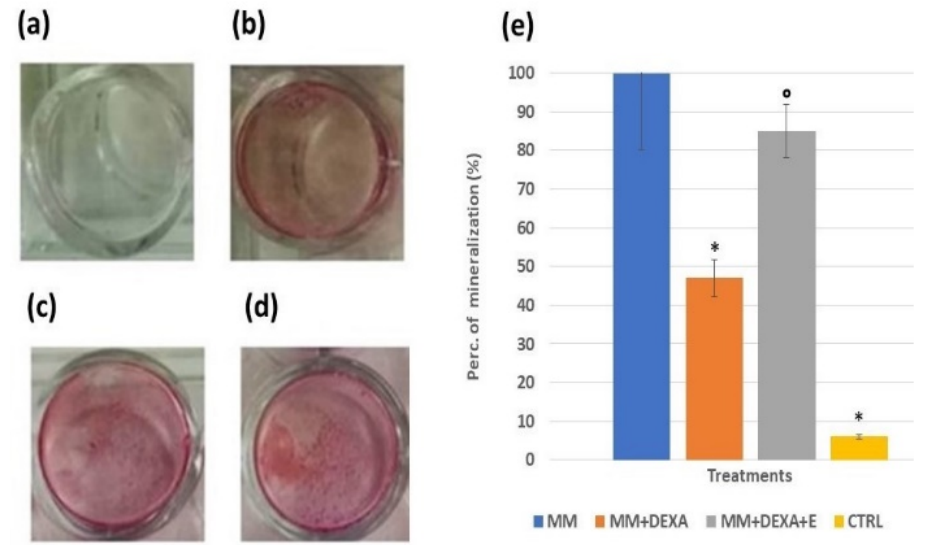
Figure 4. Mineralization assay with Alizarin red staining for calcium nodules upon treatment with the extract (2.5 mg/mL) in the presence or absence of dexamethasone (DEXA) (2 × 10 − 6 M) after 15 days of incubation in osteoblasts ‐ derived murine bone marrow cells, following differentiation. ( a ) Control condition of osteoblasts in normal medium, ( b ) DEXA in the presence of the mineralization medium (MM), ( c ) DEXA and the extract in the presence of MM, ( d ) osteoblasts culture in the pres ‐ ence of MM, ( e ) histogram showing the cytoprotective effect of the Extract against the DEXA ‐ in ‐